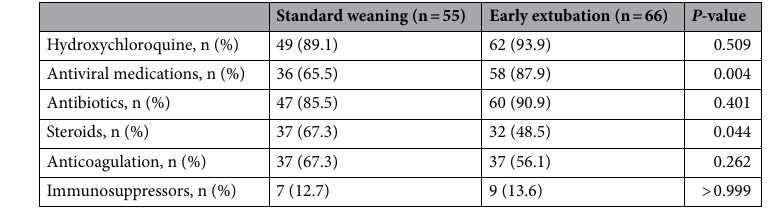
Table 3. Medical treatments. Data are presented as number and percentage of patients (in brackets) P values refer to Fisher’s exact